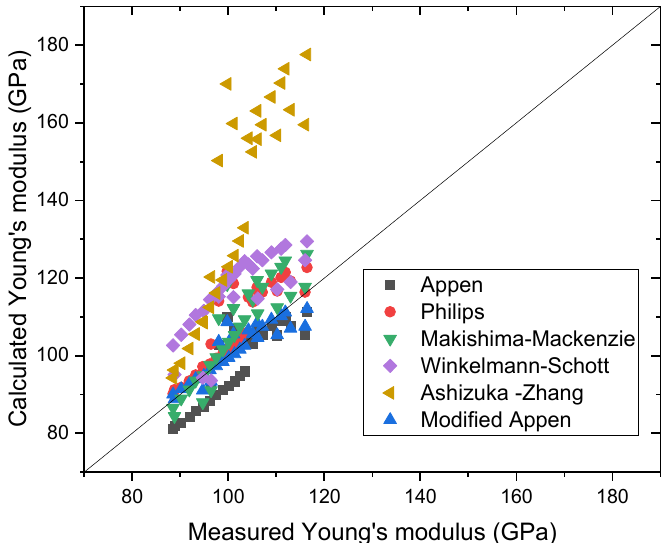
Figure 4. Comparison between measured and calculated Young’s modulus data.